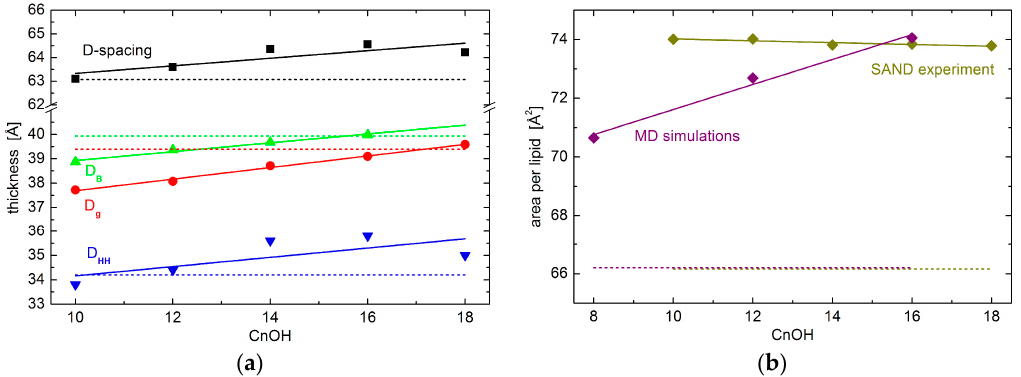
Figure 1. ( a ) Various bilayer thicknesses and ( b ) area per lipid results. The total D-spacing of lipid multilayers in excess water (black points) obtained for neat Dipalmitoyl-phoshatidylcholine (DOPC) bilayers (dashed line) and those with the addition of 0.3:1 molar ratio of tail-length varied alcohols. The alcohol tail length is depicted at the horizontal axis. The red and green data show the total bilayer thickness without interbilayer water layer obtained from small-angle neutron diffraction (SAND) and small-angle neutron scattering (SANS) [22] experiments, respectively. The blue data represent the experimentally obtained head-to-head distance. The solid lines are linear approximations of data shown to emphasize the average changes.